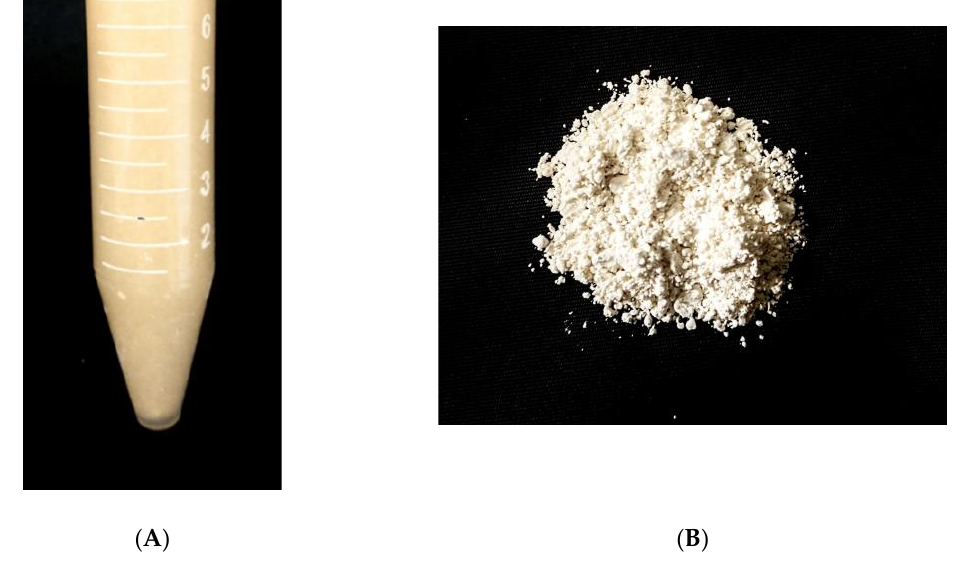
Figure 3. Nanoparticle formation ( A ) and after drying in spray dryer ( B ).